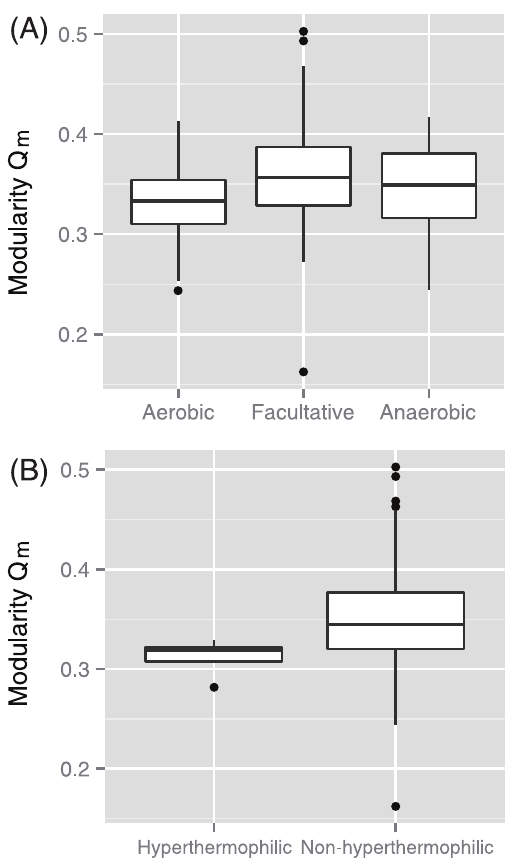
Figure 6. Differences in network modularity values due to differences in species’ growth conditions. (A) Oxygen require- ments ( p =8.7 6 10 2 8 using the Kruskal-Wallis test). The degree of oxygen required increases in the following order: anaerobic, facultative, and aerobic. (B) Growth temperature ( p =0.02 using the Wilcoxon test). Growth temperature increases from non-hyperthermophilic to hy- perthermophilic.